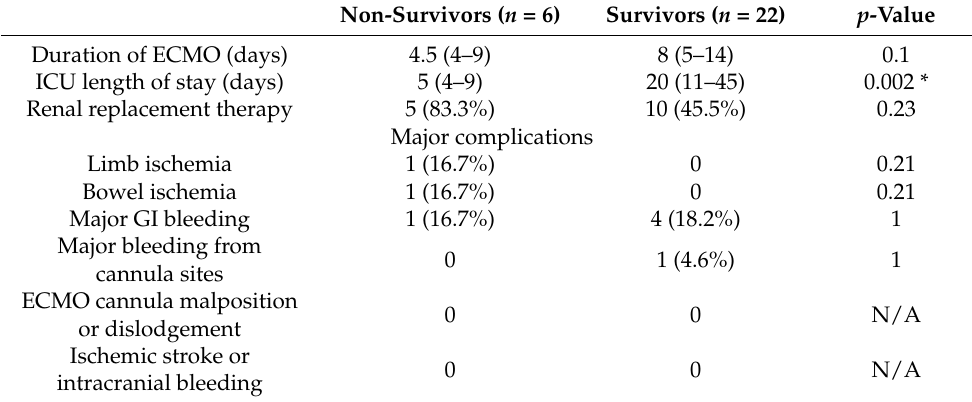
Table 2. Clinical outcomes and incidence of major